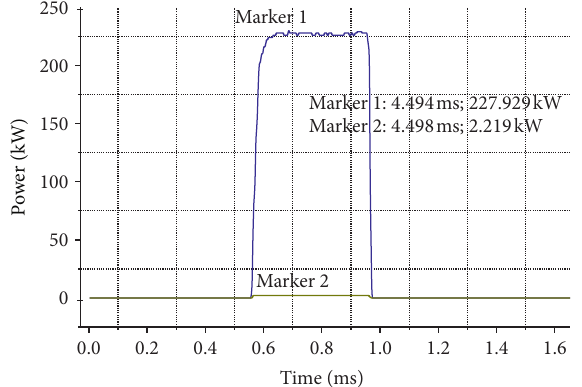
Figure 8: High-power pulse experiment results.